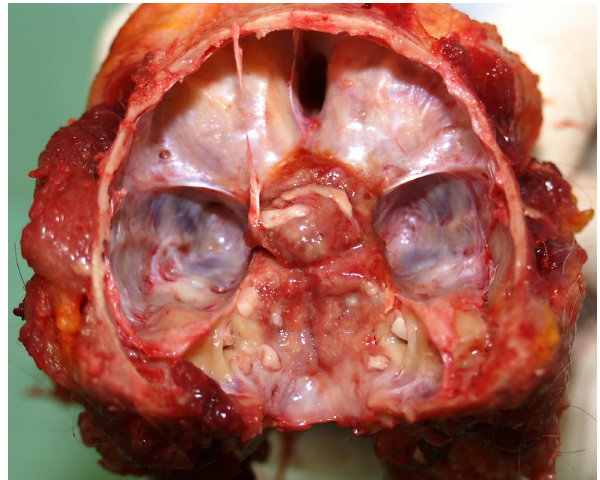
Figure 1. View of the cranial base of an old pig-tailed macaque (brain removed): the meningioma was located around the hypophy- seal stalk involving the optic chiasm.